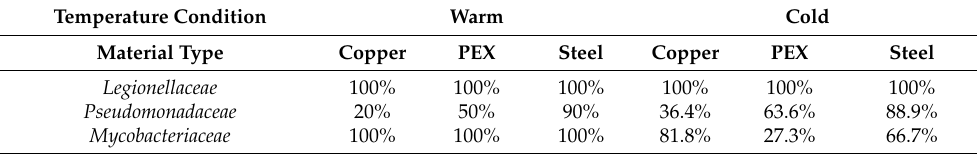
Figure 3. Mean relative abundance of the ten most abundant classes of bacteria in the model DWDSs. (Based on the average relative abundance of all samples for each DWDS). Table 1. Frequency of detection of OPs on family taxon level across the 6 model